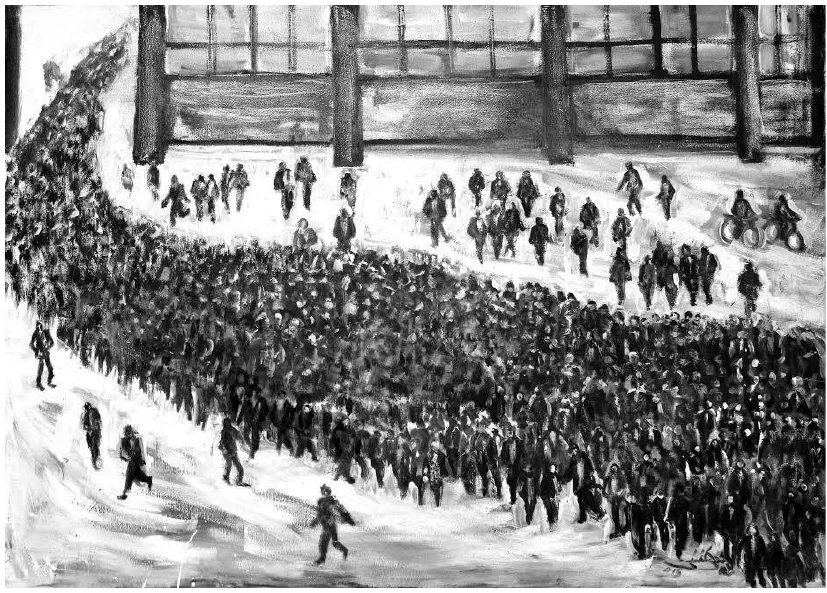
Figure 1 .Fathi Afifi: Oil on Canvas, 100 x 70 cm